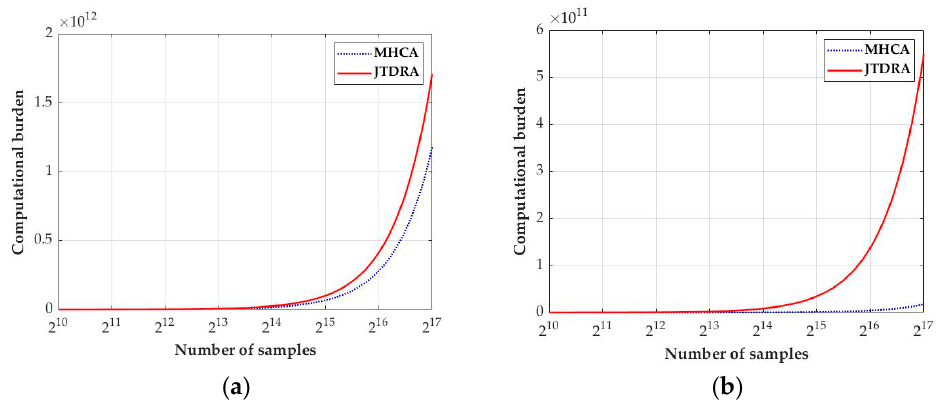
(44) Table 5. Analysis of the computational complexity for different algorithms.